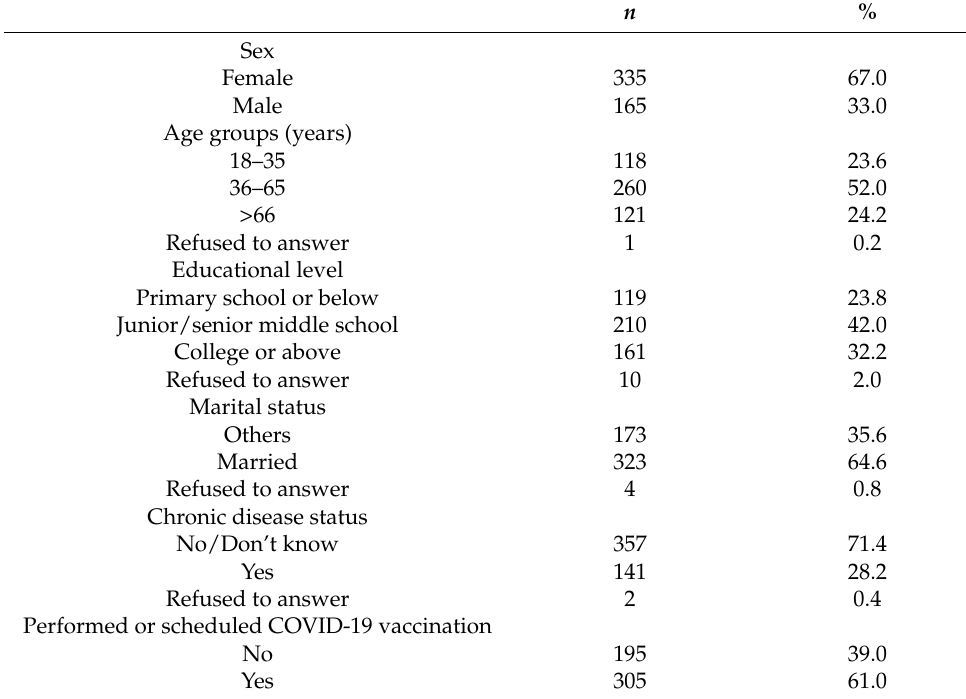
Table 1. Characteristics of the participants of the validation survey ( n =